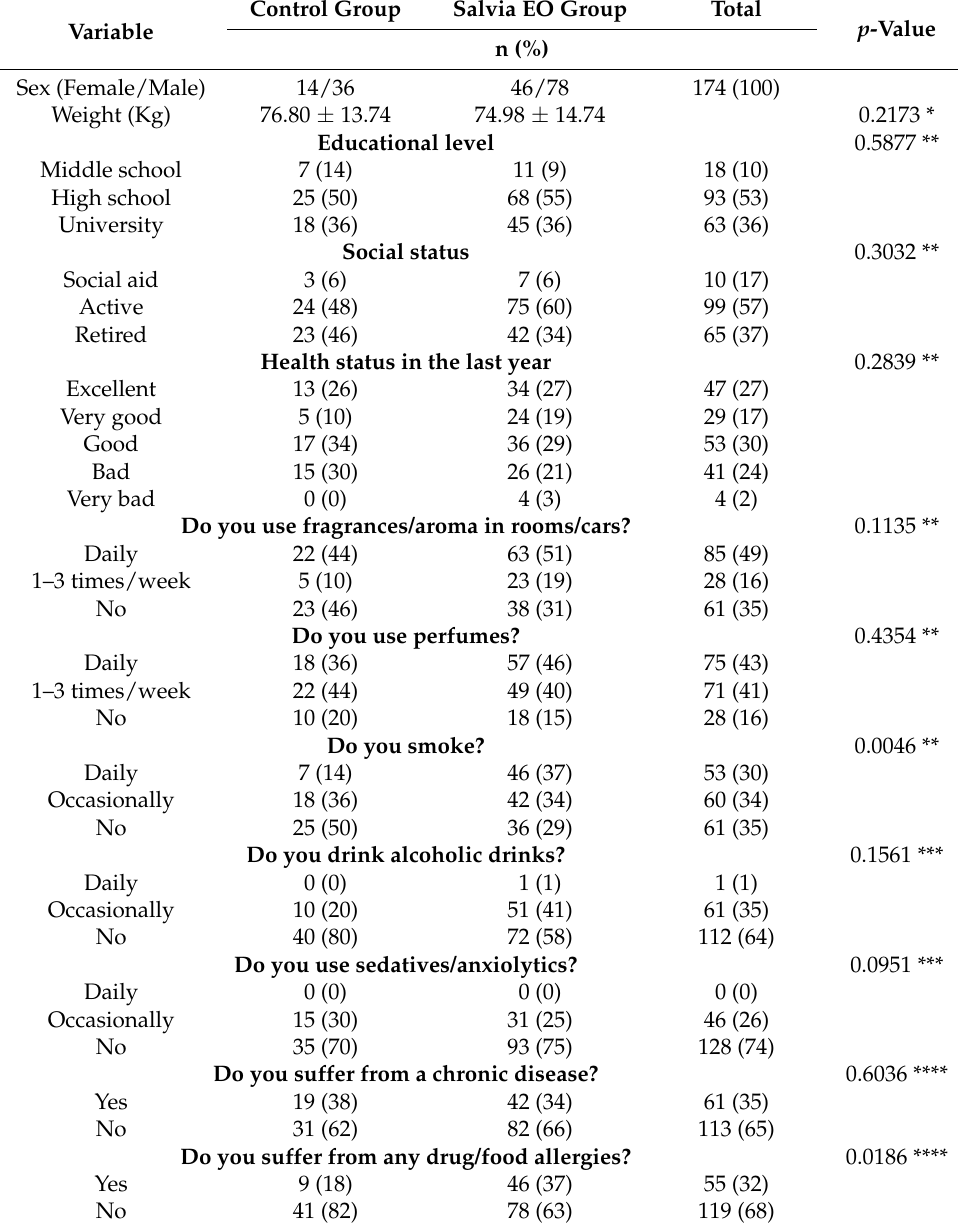
Table 3. Patients’ demographic and clinical